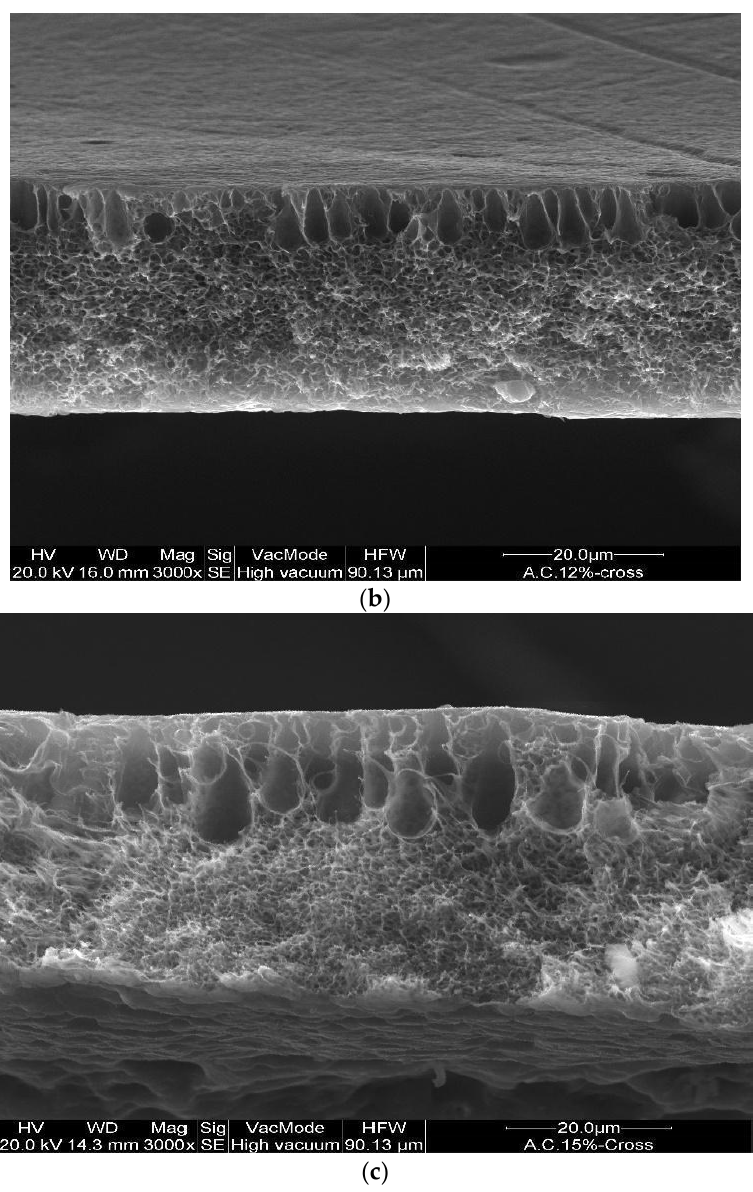
Figure 2. Cross-section of the asymmetric CA membranes at different polymer concentration: ( a ) 10 wt% ( b ) 12 wt% and ( c ) 15 wt%.